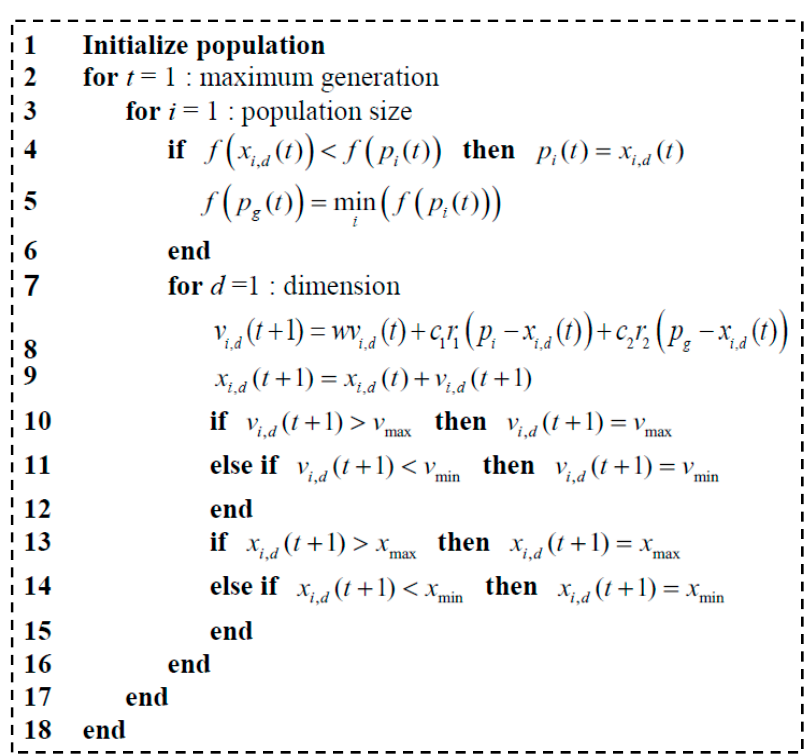
Figure 1. Pseudocode of standard particle swarm optimization.